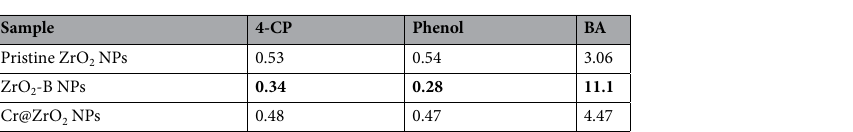
Table 1. PCD activities (initial degradation rates (μM min −1 )) of the evaluated samples after 3 h. The experimental uncertainties are within 5%. The experimental conditions corresponded to